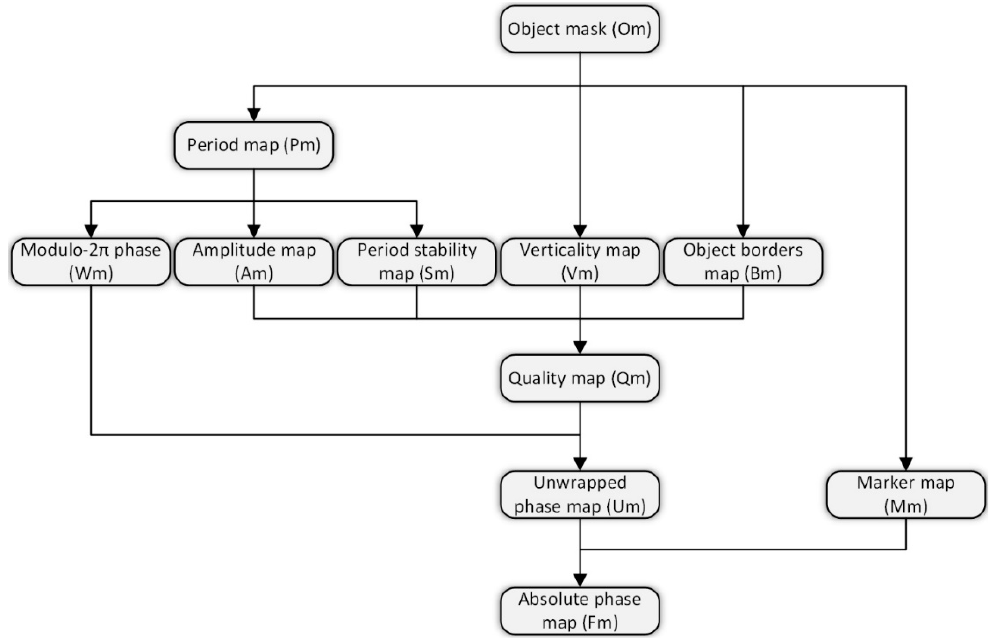
Figure 5. Single-frame processing scheme.